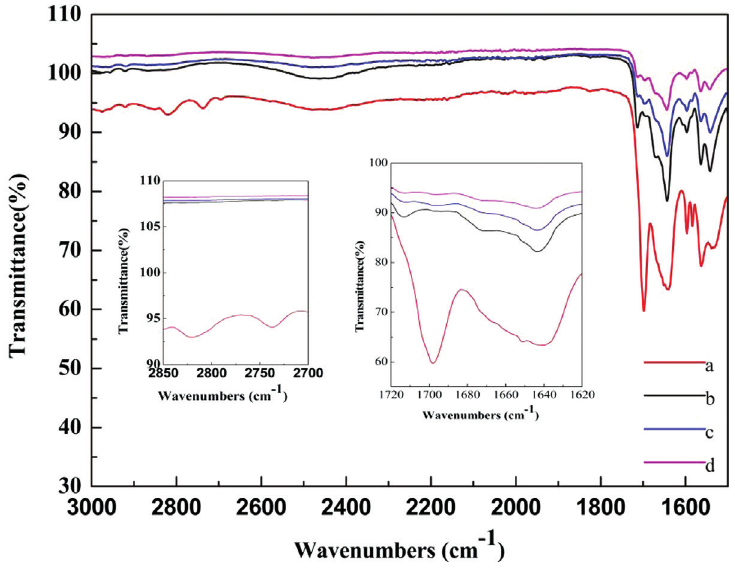
Figure 4: IR spectra of benzaldehyde, urea and ChCl/2PTSA. Reaction condition: aldehyde (2.0 mmol), urea (3.0 mmol), ChCl/2PTSA (0.6 mmol), 70°C; a: initial mixtures, b: heating for 10 min, c: heating for 20 min, d: heating for 30